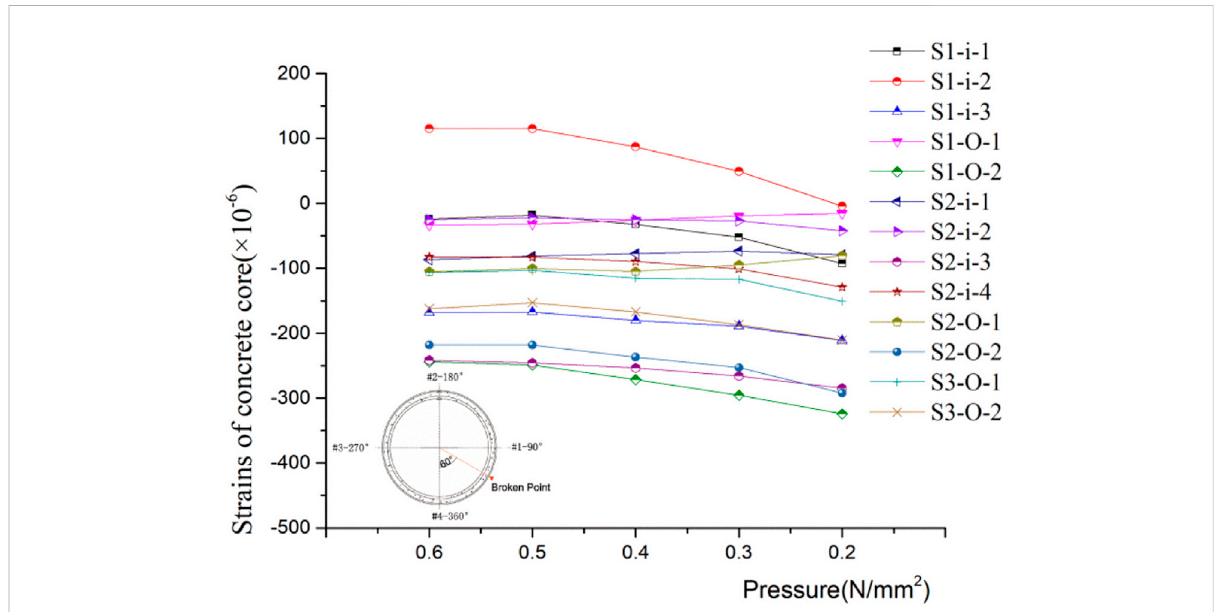
FIGURE 16 Strain curves of the concrete core with the rate of broken wires.